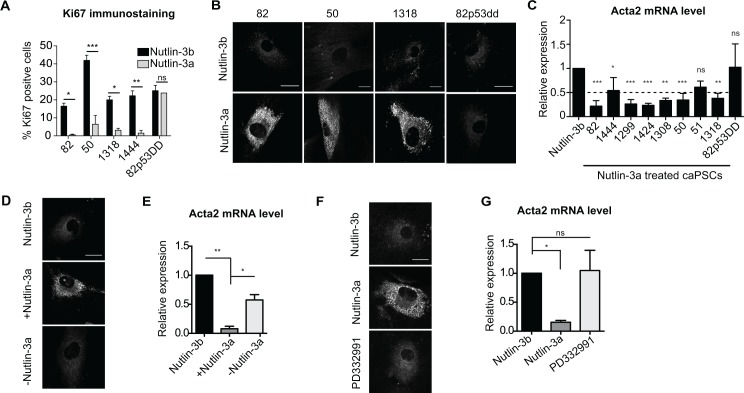
p53 reprograms human caPSCs towards quiescence.caPSCs were treated with Nutlin-3a, Nutlin-3b (control) or PD332991 for 48h (C, G) or 72h (A,B, F). (A) Cells were immunostained for Ki67 and nuclei were stained with DAPI. Bar graph represents the percentage of nuclei positive for the Ki67 antigen. At least 100 cells per condition were counted. Values are plotted as mean +SD of at least 2 experiments. ***, p<0.001; **, p<0.01; *, p<0.05 by two-way ANOVA. (B) Representative images of caPSCs stained with BODIPY 493/503 for detection of neutral lipids. (C) Acta2 mRNA levels were quantified by RT-qPCR. Values were normalized to Rplp0 mRNA levels and are represented as fold change relative to Nutlin-3b treated cells. Bars indicate mean +SD of at least 3 experiments. ***, p<0.001; **, p<0.01; *, p<0.05 by one-way ANOVA. (D-E) caPSCs were treated with Nutlin-3a or Nutlin-3b for 72h. Nutlin-3a was removed from treated caPSCs and cells were cultured for an additional 72h with (+) or without (-) Nutlin-3a. (D) Representative images of cells stained with BODIPY 493/503 (E) Acta2 mRNA levels were quantified and represented as described in C. (F) Representative images of cells stained with BODIPY 493/503. (G) Acta2 mRNA levels were quantified and represented as described in C. Scale bars, 25 μM.